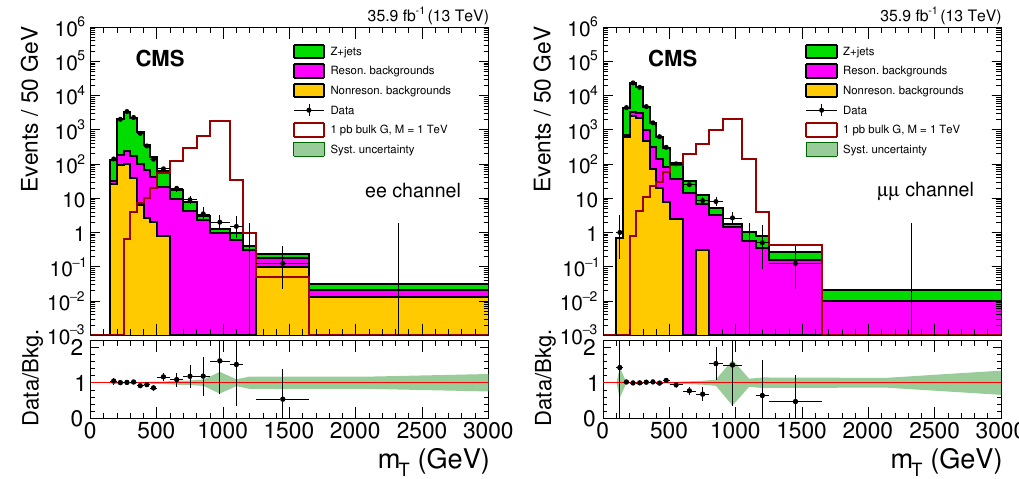
Figure 4 . The m T distributions for electron (left) and muon (right) channels comparing the data and background model based on control samples in data, after (cid:12)tting the background-only model to the data. The expected distribution for a zero width bulk graviton resonance with a mass of 1 TeV is also shown for a value of 1 pb for the product of branching fraction and cross section (cid:27) (pp ! X ! ZZ) B (ZZ ! 2 ‘ 2 (cid:23) ). The lower panels show the ratio of data to the prediction for the background. The shaded bands show the systematic uncertainties in the background, while the statistical uncertainty in the data is shown by the error